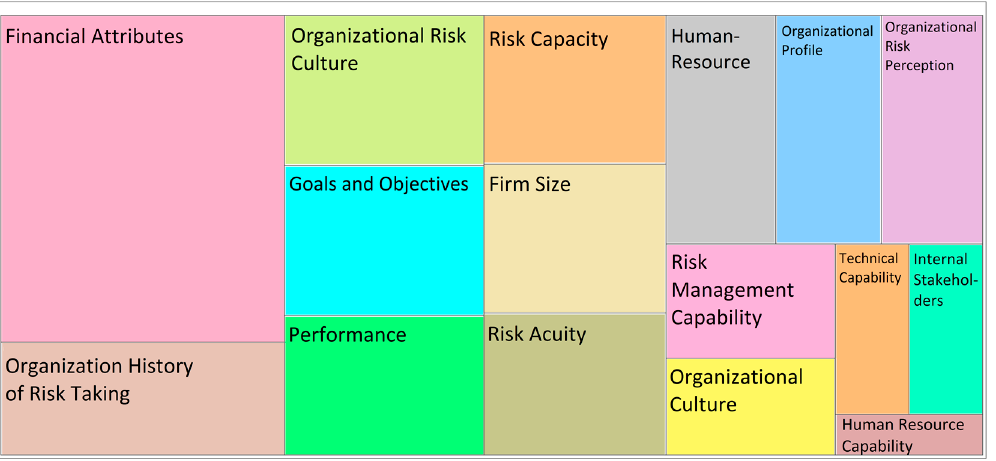
Figure 8. Hierarchy chart of organizational factors.